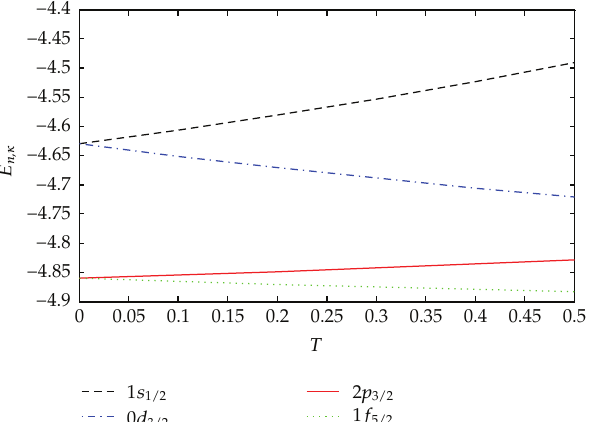
Figure 4: The variation of the energy levels as a function T in the presence of pseudospin